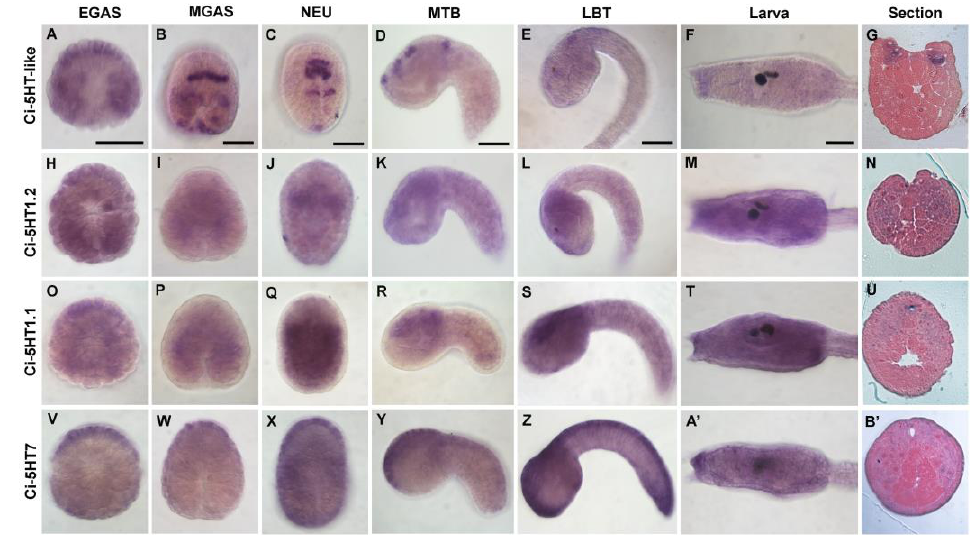
Figure 2. Expression profile of serotonin receptors during C. intestinalis development. Expression of 5HTRs by whole mount in situ hybridization in five developmental stages: early gastrula stage (EGAS) ( A , H , O , V ); mid gastrula stage (MGAS) ( B , I , P , W ); neurula stage (NEU) ( C , J , Q , X ); mid-tailbud stage (MTB) ( D , K , R , Y ); late tailbud stage (LTB) ( E , L , S , Z ); and larva stage (only trunk and the beginning of the tail is shown; F , M , T , A’ ). Representative microscopy transverse sections of hybridized samples are shown in G (neurula stage), N (initial tailbud stage), and U and B’ (mid-tailbud stage). Scale bars: 25 µm ( B – E ); 50 µm ( A , F ).